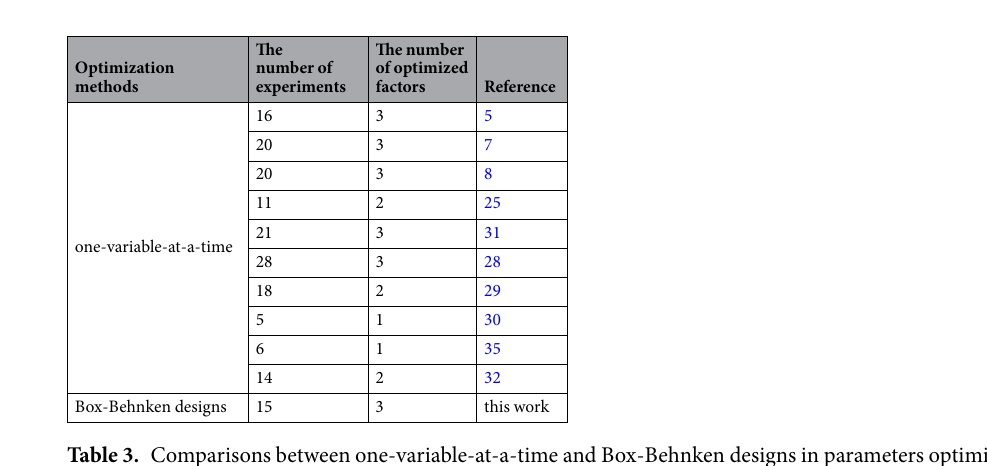
Figure 4. ( A ) DPASV determination on lead(II) without the removal of oxygen in 0.1 mol/L HCl; ( B ) Curves from part ( A ) after background subtraction.